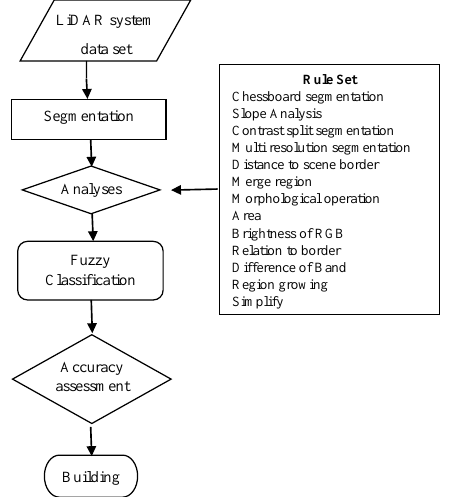
Figure 1. The workflow of the proposed automatic building extraction strategy with multi sensor systems